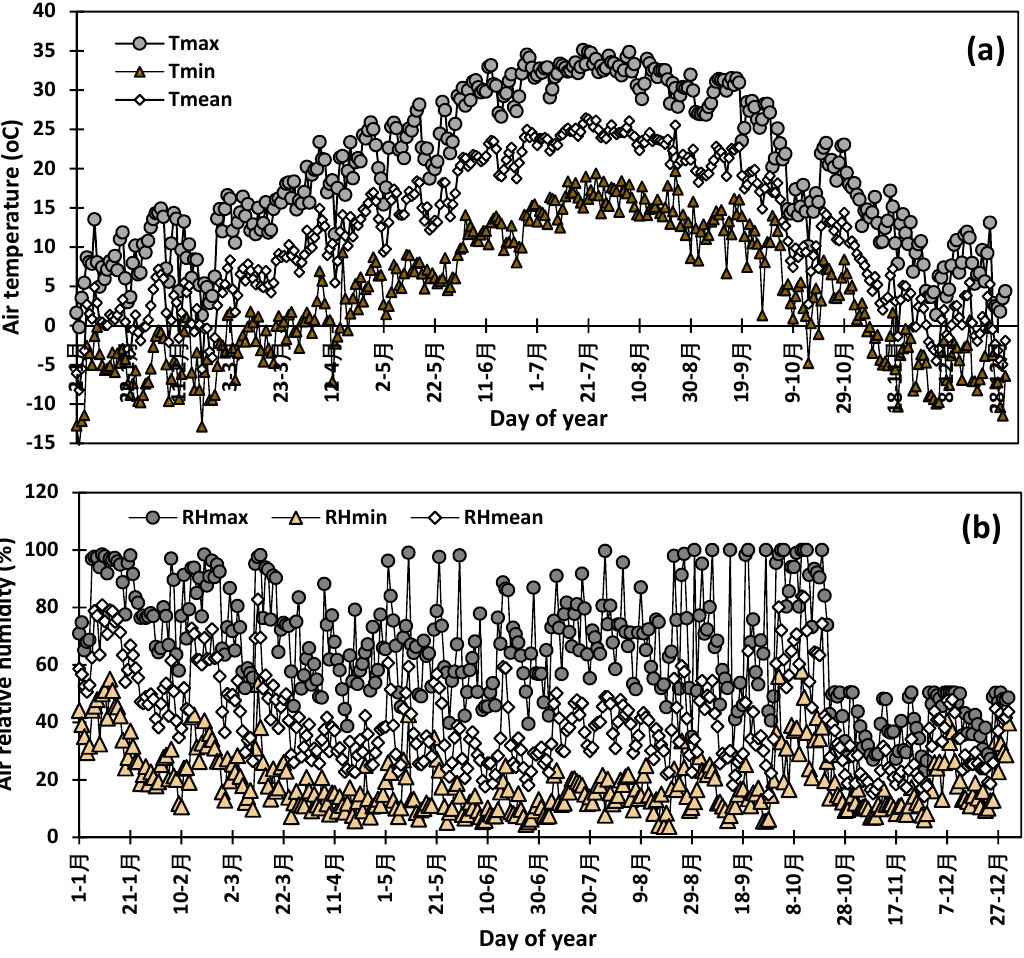
Figure 1. Average air temperature ( a ) and average air relative humidity during the study period ( b ).